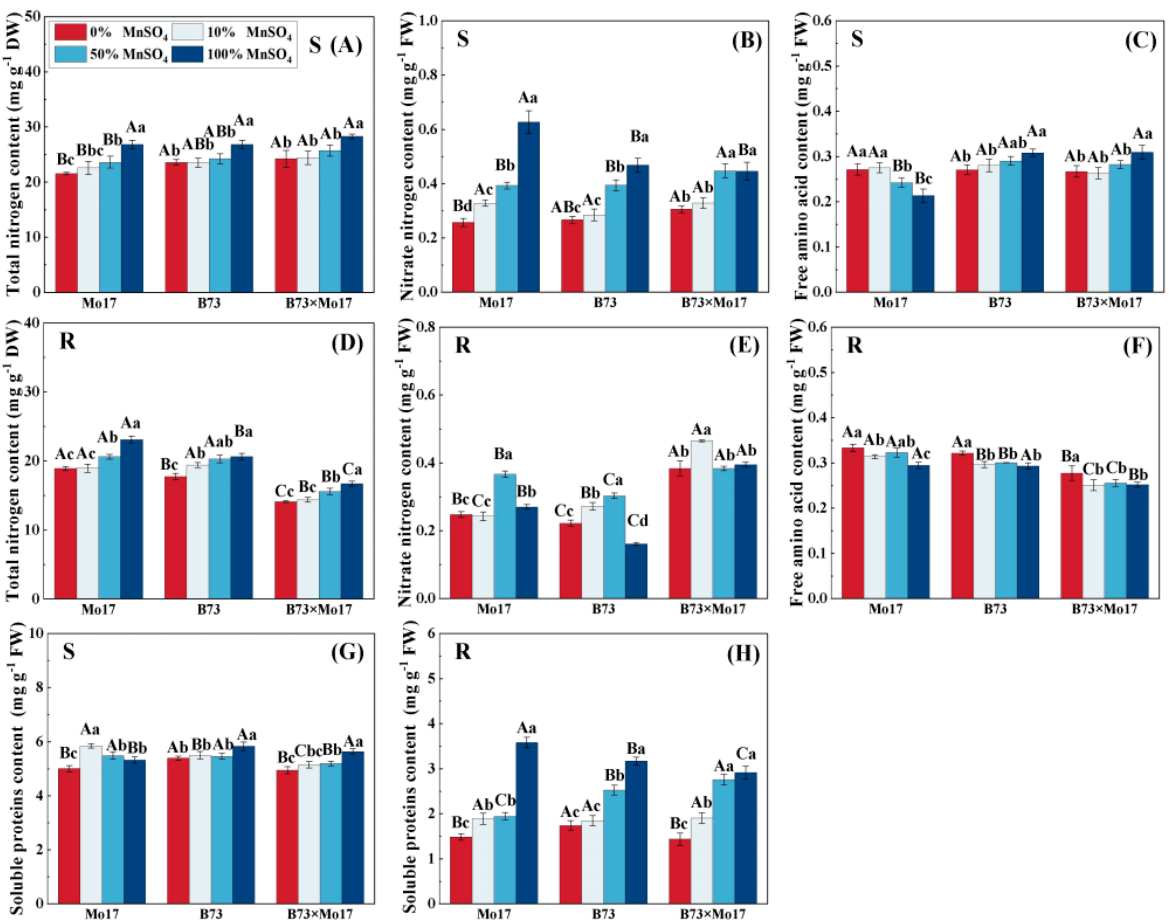
Figure 6. Effect of Mn deficiency on the content of nitrogenous compounds in nitrogen metabolism of maize seedlings. Total nitrogen content ( A , D ), nitrate nitrogen content ( B , E ), free amino acid con-tent ( C , F ), soluble proteins content ( G , H ). According to the LSD test different capital letters: signif-icant difference between varieties ( p < 0.05); different lowercase letters: significant difference be-tween MnSO 4 treatments ( p < 0.05). S represents leaf-related parameters, R indicates root-related parameters.